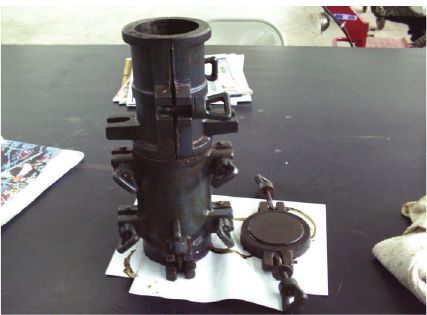
Figure 2: Soil compaction mould assembly modified from concrete specimen mould.